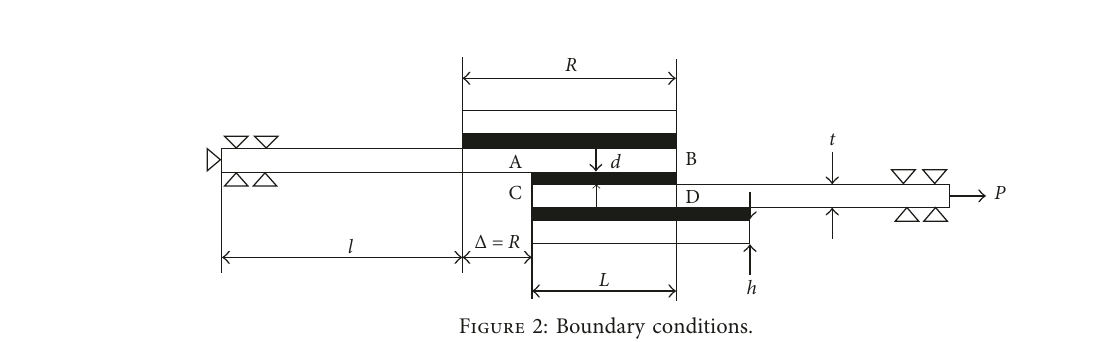
Figure 2: Boundary conditions.